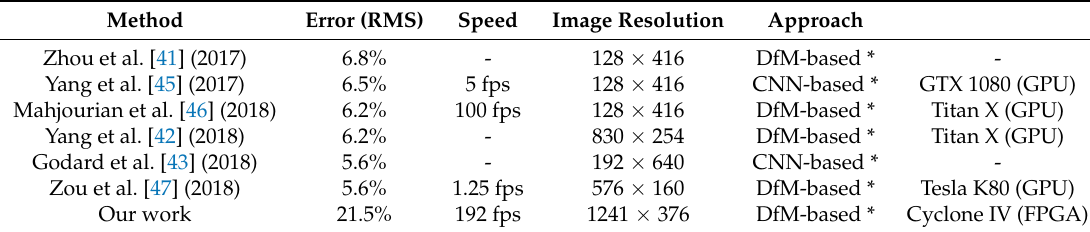
Table 5. Depth estimation process in the literature: performance and limitations for the KITTI dataset.